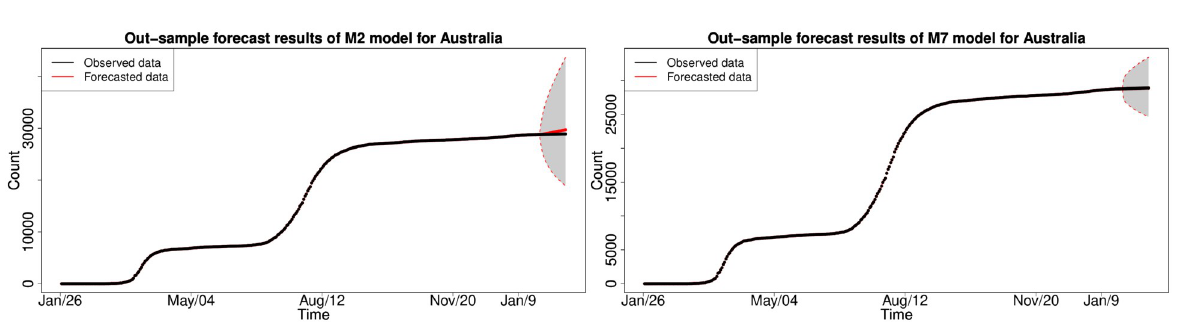
Fig 17. Out-of-sample forecast results for Australia. Out-of-sample forecast plot for the Australia by Model 2 (left) and Model 7 (right).